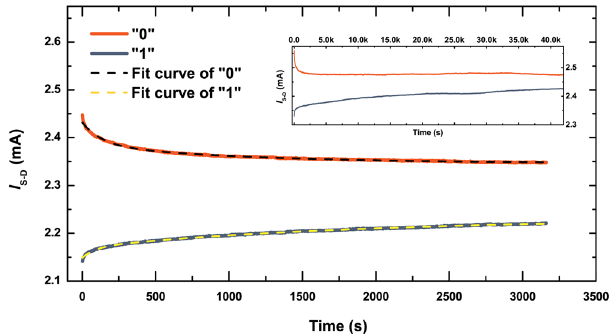
Figure 4. Data retention following write and erase. Time evolution of the “0” and “1” states as measured by the source-drain current, I S-D , (solid orange and navy lines, respectively) follow double-exponential decay (dashed lines) with asymptotic values that do not converge. Data was taken with 1.0 V source-drain bias and zero bias on the control gate. The inset shows an example of an overnight measurement ( > 12